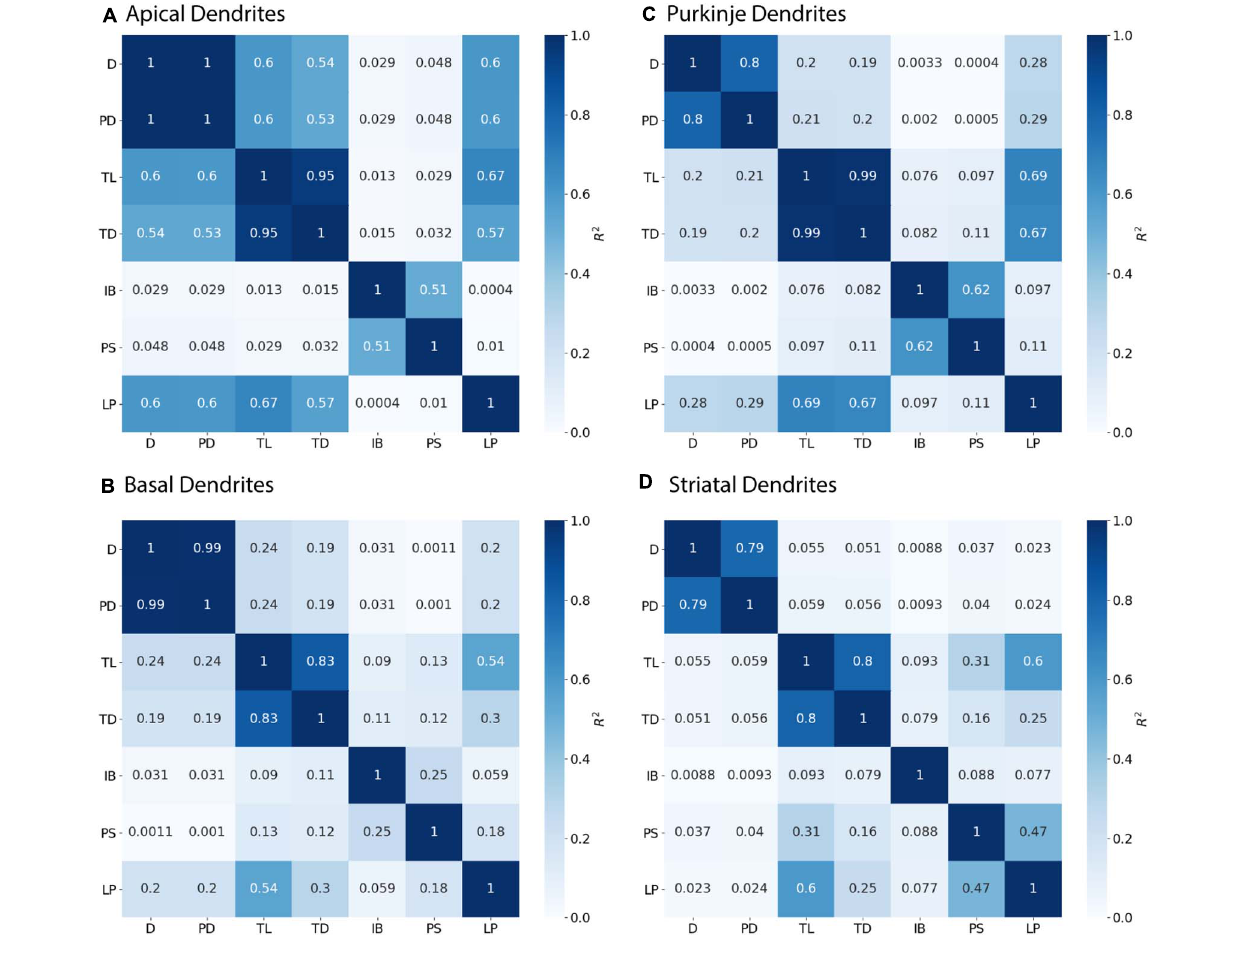
( R 2 = 0.800), and striatal SPNs ( R 2 = 0.788) indicate PD as a strong predictor of continuing node diameter ( Figure 4